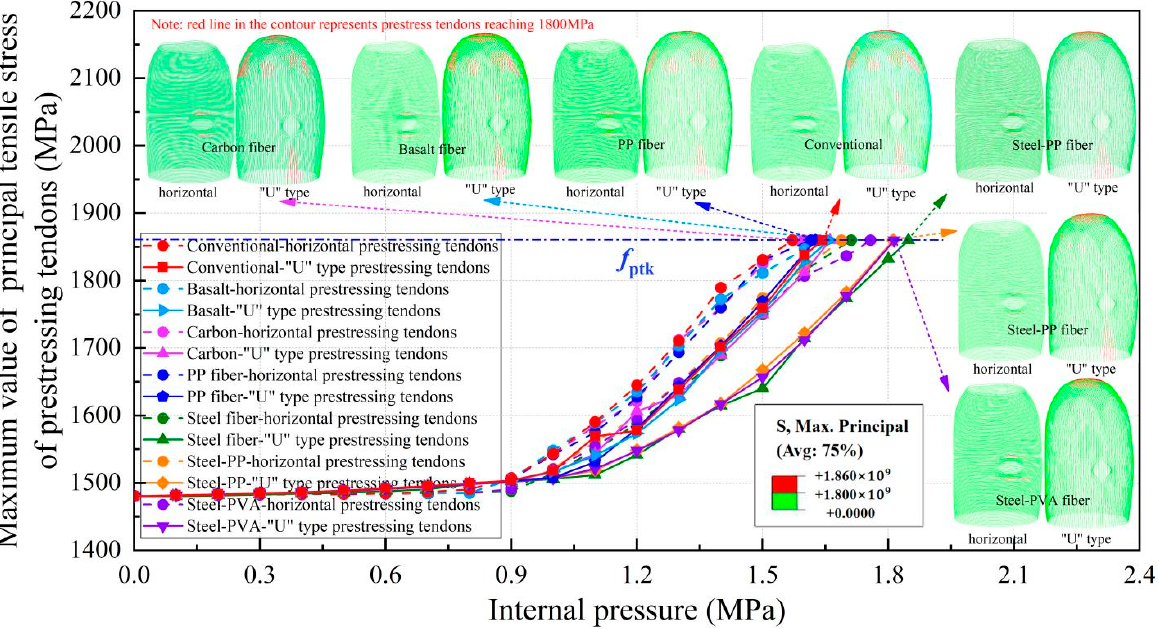
Figure 16. The variations in prestressed tendons’ maximum principal